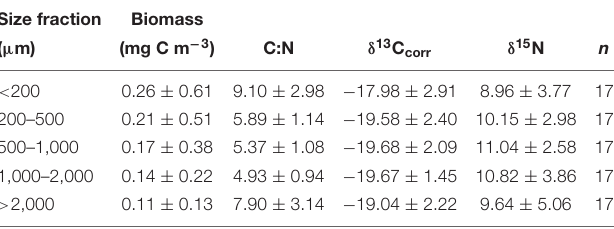
TABLE 3 | Size-fractioned zooplankton biomass (mean ± SD) and their isotopes composition of C and N. Biomass is in terms of C, the C/N ratio and isotopic composition of δ 13 C and δ 15 N.